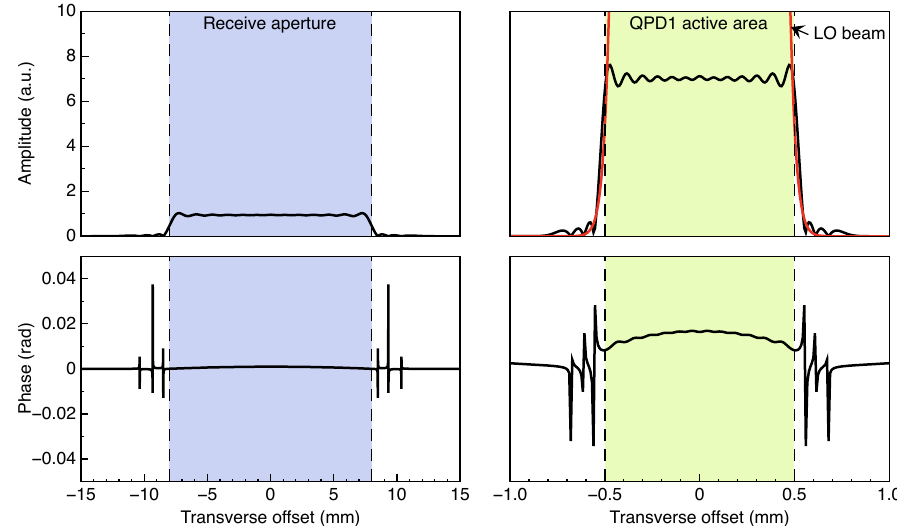
Figure 3. Amplitude and phase of the “flat-top” RX beam at the receive aperture and at the surface of QPD1, in the horizontal direction. The dashed lines indicate the boundaries of the aperture and the active area of the photodiode, respectively. The RX beam is modeled in IFOCAD using the mode- expansion method. The amplitude of the local oscillator beam at QPD1 is shown in red, showing good spatial overlap with the RX beam, in spite of the much larger peak amplitude.